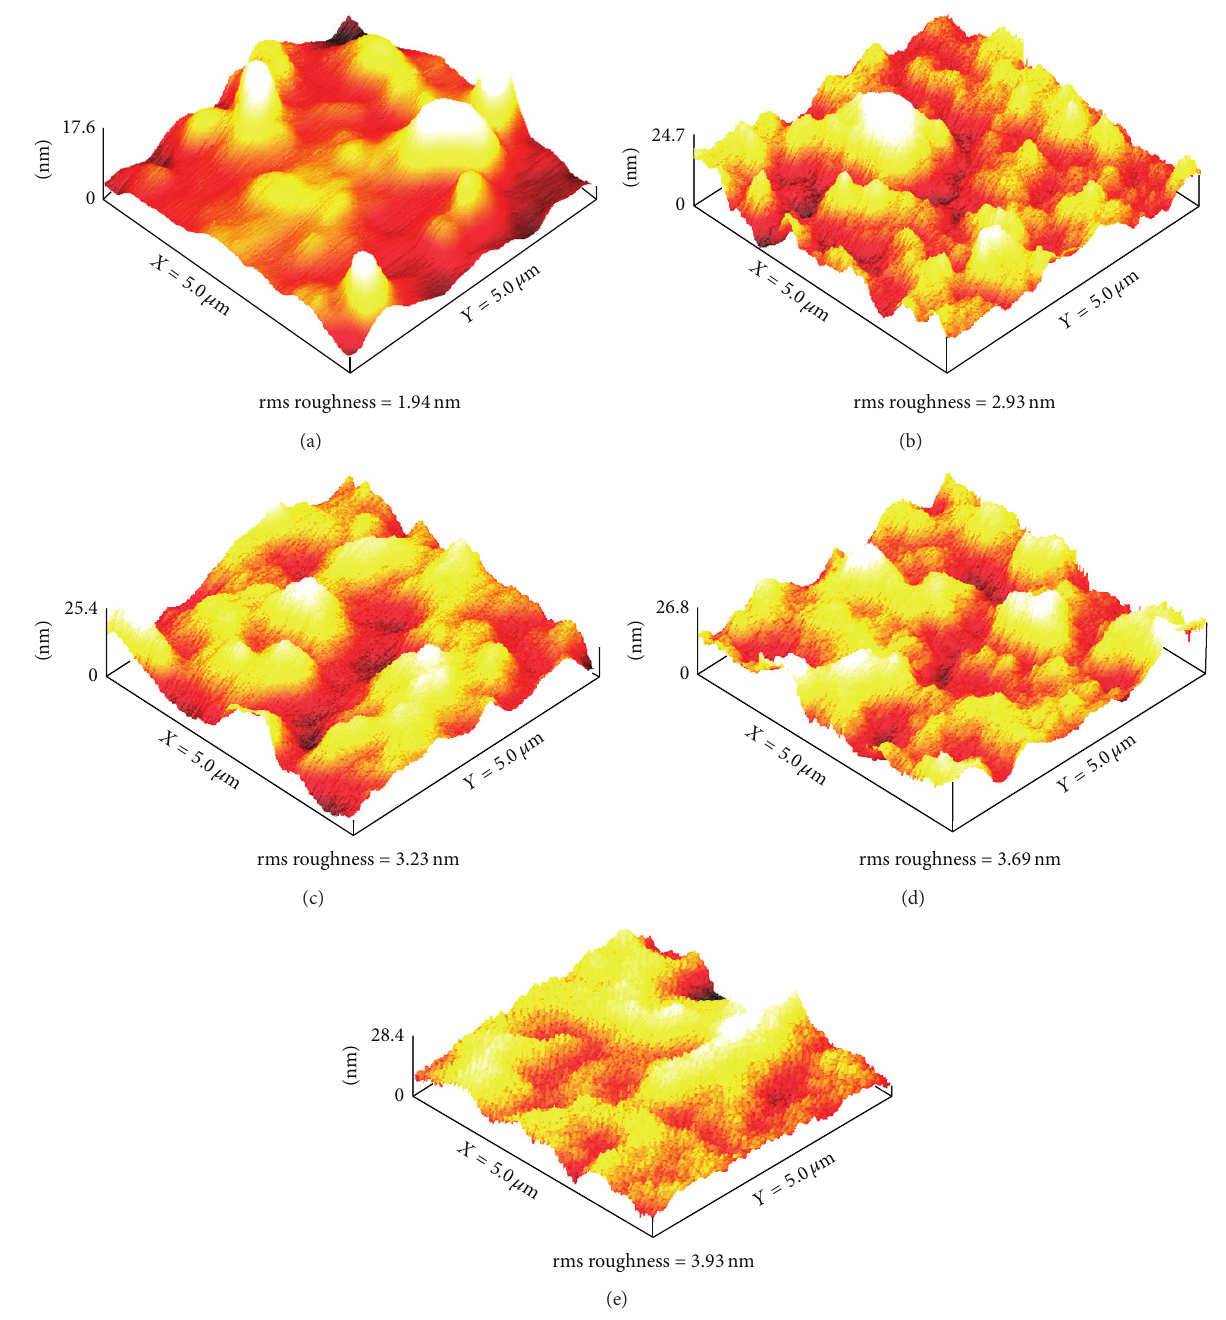
Figure 7: AFM images and rms surface roughness of the absorption layers with the pentacene doping ratio of (a) 0, (b) 0.05, (c) 0.06, (d) 0.065, and (e) 0.07 by